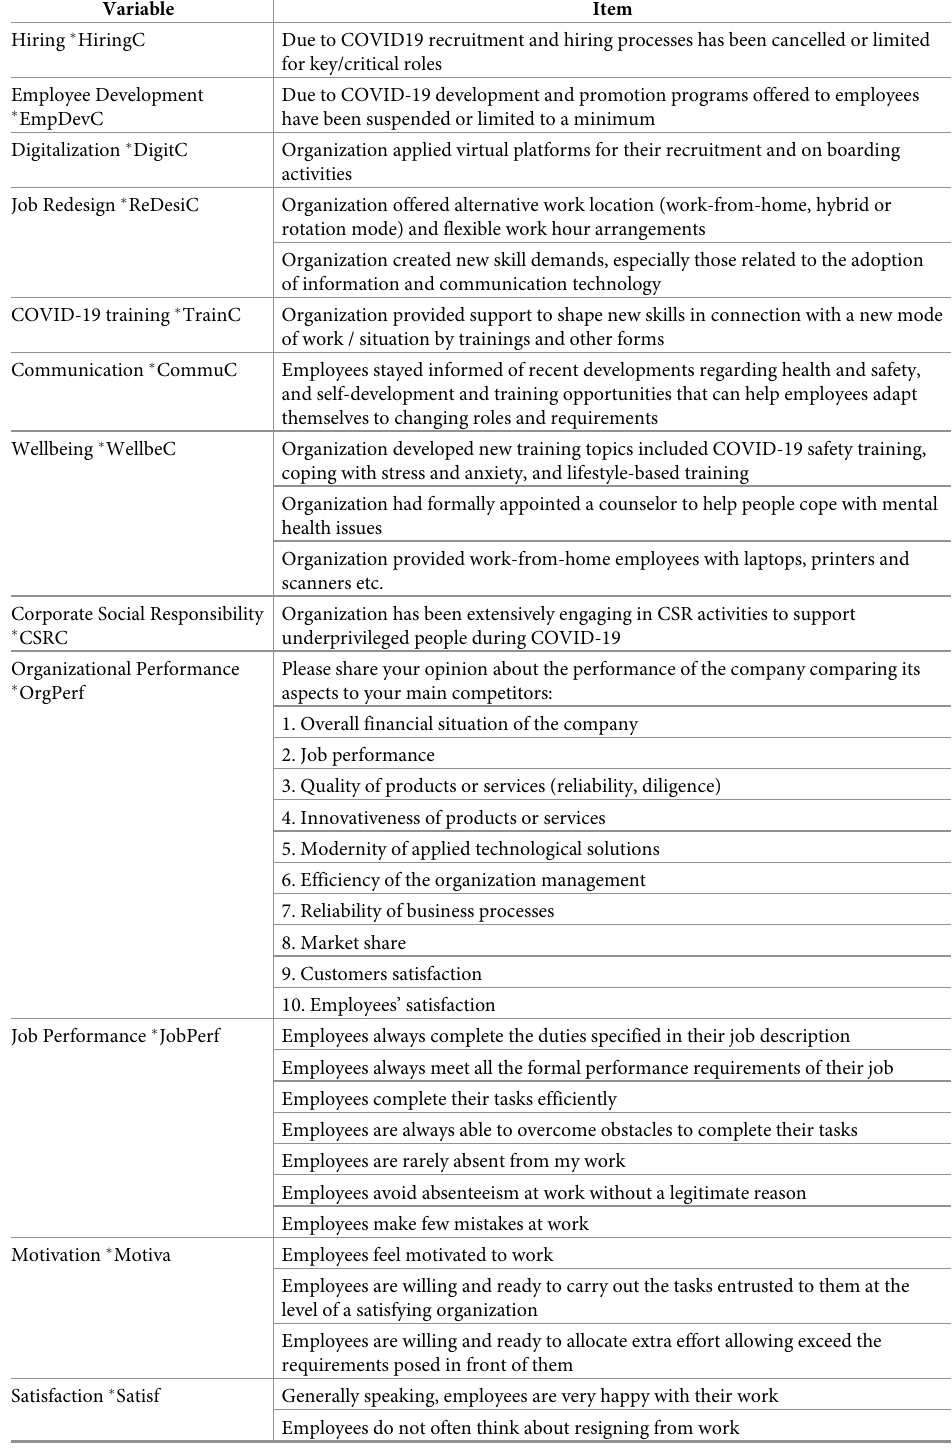
Table 2. Summary of the items and the corresponding